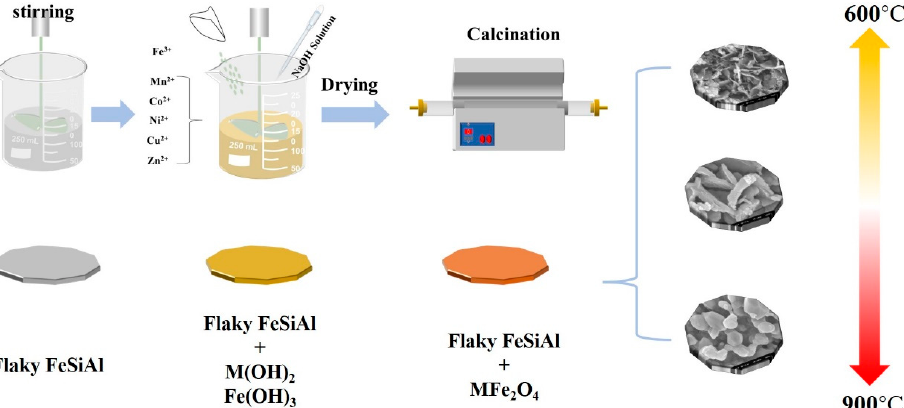
Figure 1. The schematic illustration of the evolution of MFe 2 O 4 (M = Zn, Cu, Ni, Co and Mn)-coated flaky FeSiAl composites.